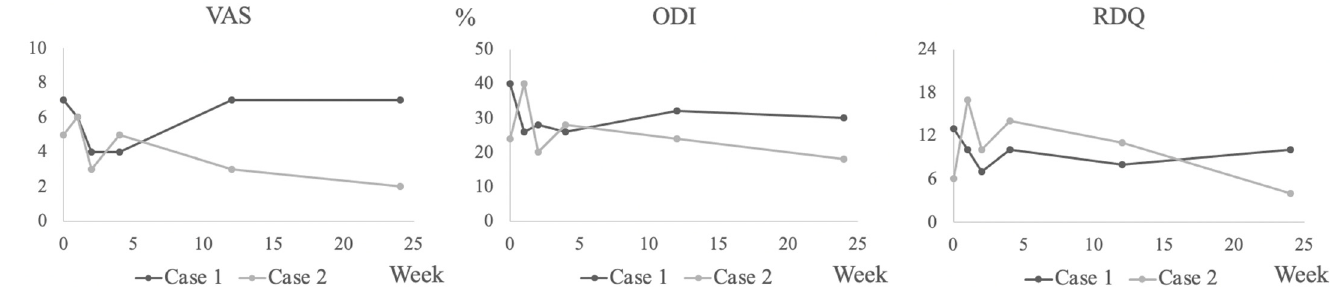
Figure 5. Scores of the VAS, ODI, and RDQ in case 1 and case 2. The VAS, ODI, and RDQ for case 1 and case 2 are shown. After PRP administration, the VAS in case 1 improved temporarily but returned to the same level as before administration at the last observation. All other scores in case 1 improved at the last observation compared to the pre-administration level. All scores in case 2 wors-